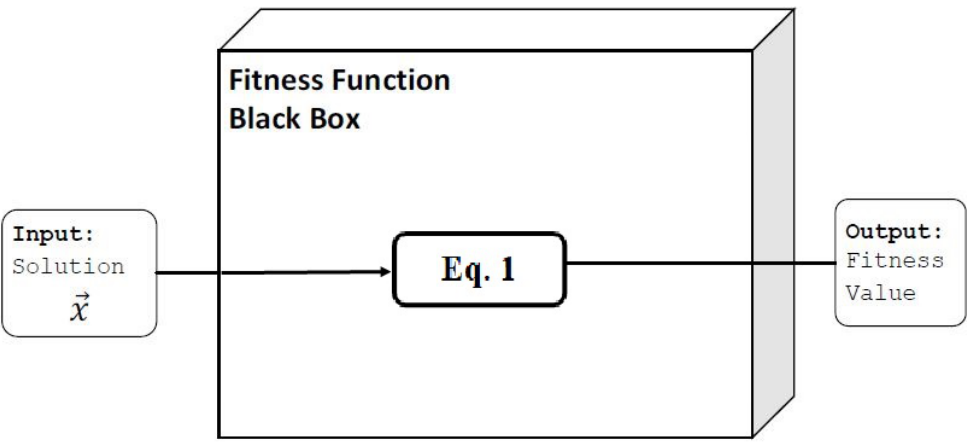
Fig. 3: Fitness function as black box Figure 3. Fitness function as black